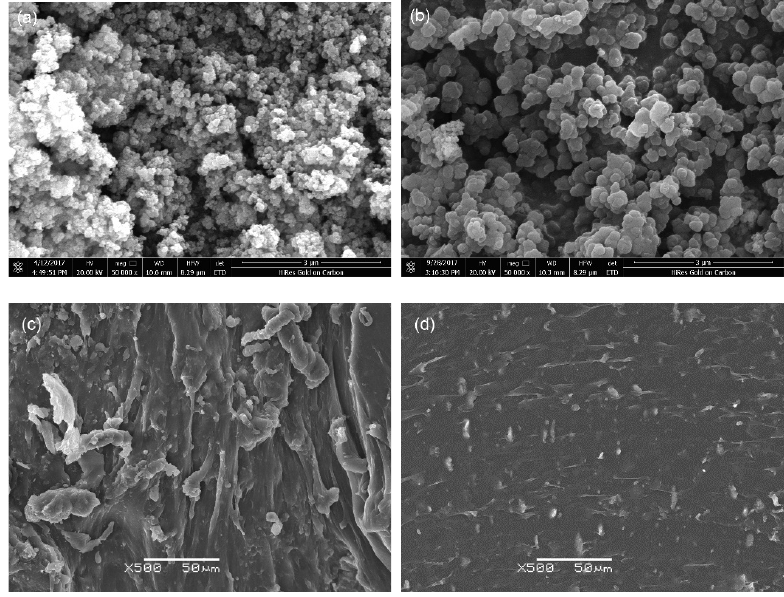
Figure 3. SEM images of TiC ( a ), PDA@TiC − 60 ( b ), TiC/TPU − 13 ( c ) and PDA@TiC − 60/TPU − 13 ( d ). Table 1. EDS results of TiC and PDA@TiC − 60.